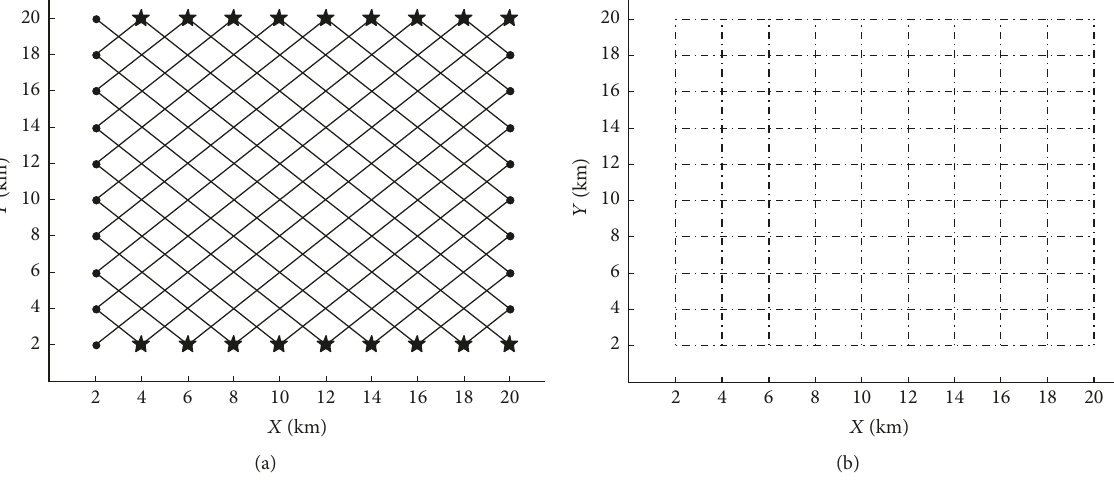
Figure 4: (a) The monitoring area of the microwave link network; (b) discretized monitor area. There were 34 microwave links in the simulation area. The monitoring area was divided into many 2 × 2km square grids.